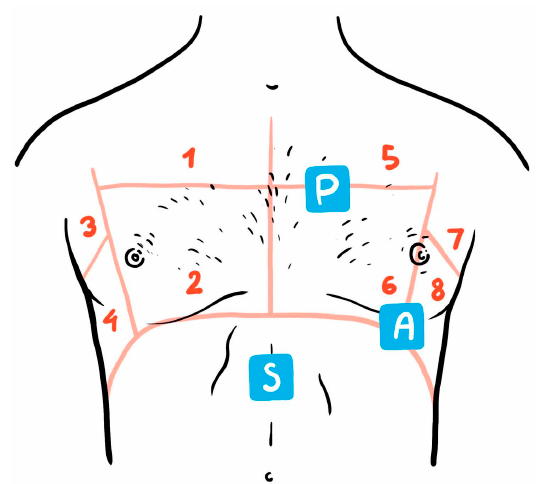
Figure 2. Lung UltraSound (LUS) applying the eight chest zone method and the Point-of-care Cardiac UltraSound examination (FoCUS) with the main examination windows (P–parasternal long and short axis views; A-apical four-chamber view; S-subcostal views of inferior vena cava and cardiac four-chamber) [53]. four-chamber)